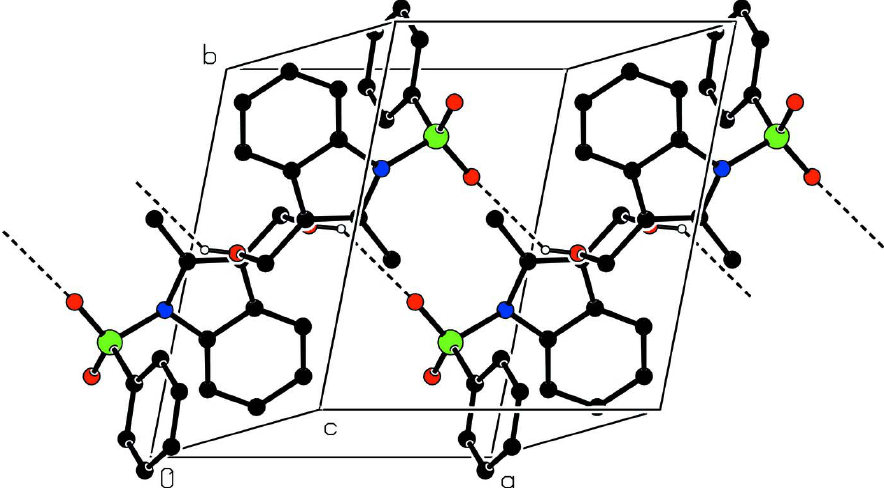
Figure 2 The packing of (I), viewed down the c axis. H-bonds are shown as dashed lines; H atoms not involved in hydrogen bonding have been